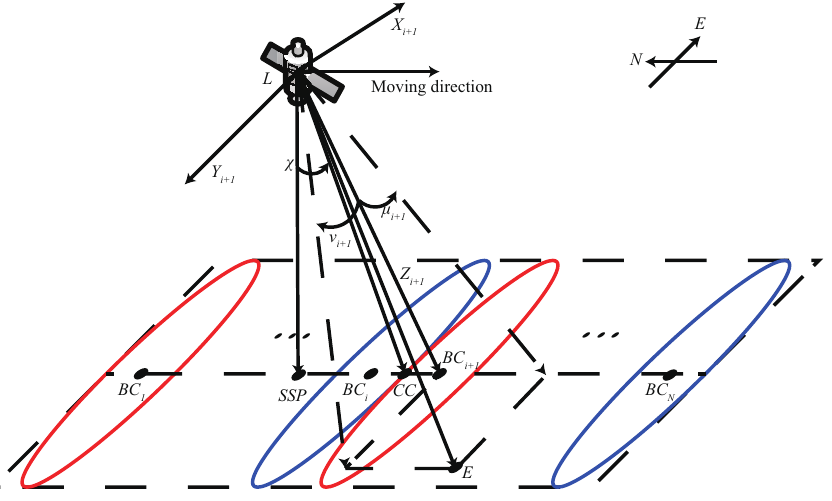
Figure 1. The coverage of LEO satellite with the pitch angle being χ